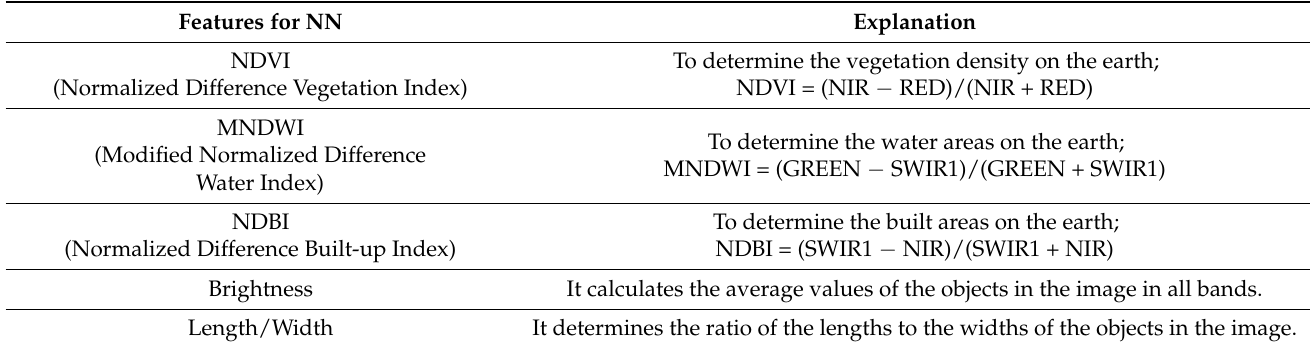
Table 2. Features for nearest neighbor classification.